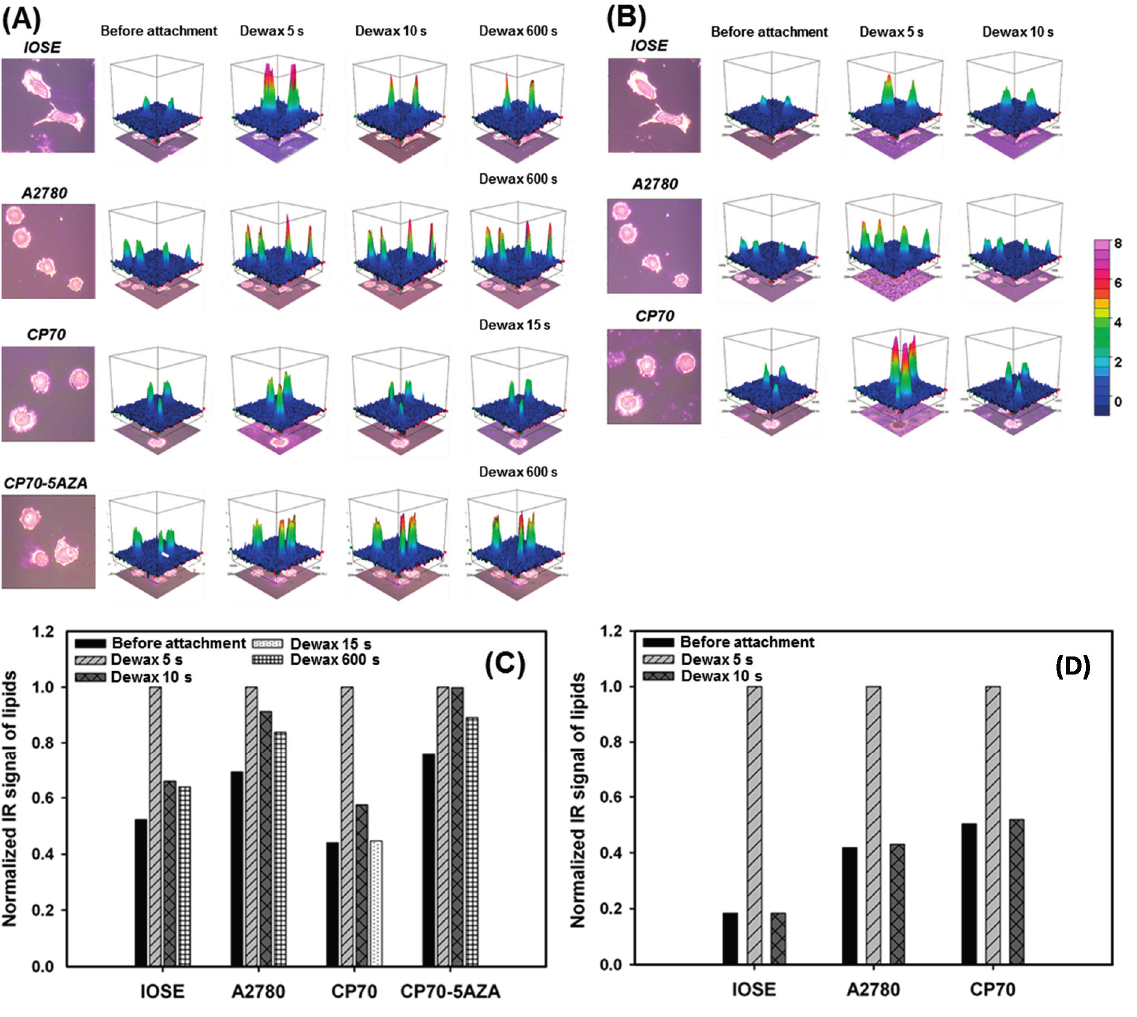
Figure 4. Wax-adsorption kinetic study of ( A ) paraffin ( B ) beeswax compared among IOSE, CP70 and A2780 cell lines at different de-waxing time. De-waxing was performed with xylene-wash after wax-fixing. The amount of wax was determined by integration of absorbance from 2800 to 3000 cm − 1 ; The quantitation of ( C ) paraffin or ( D )